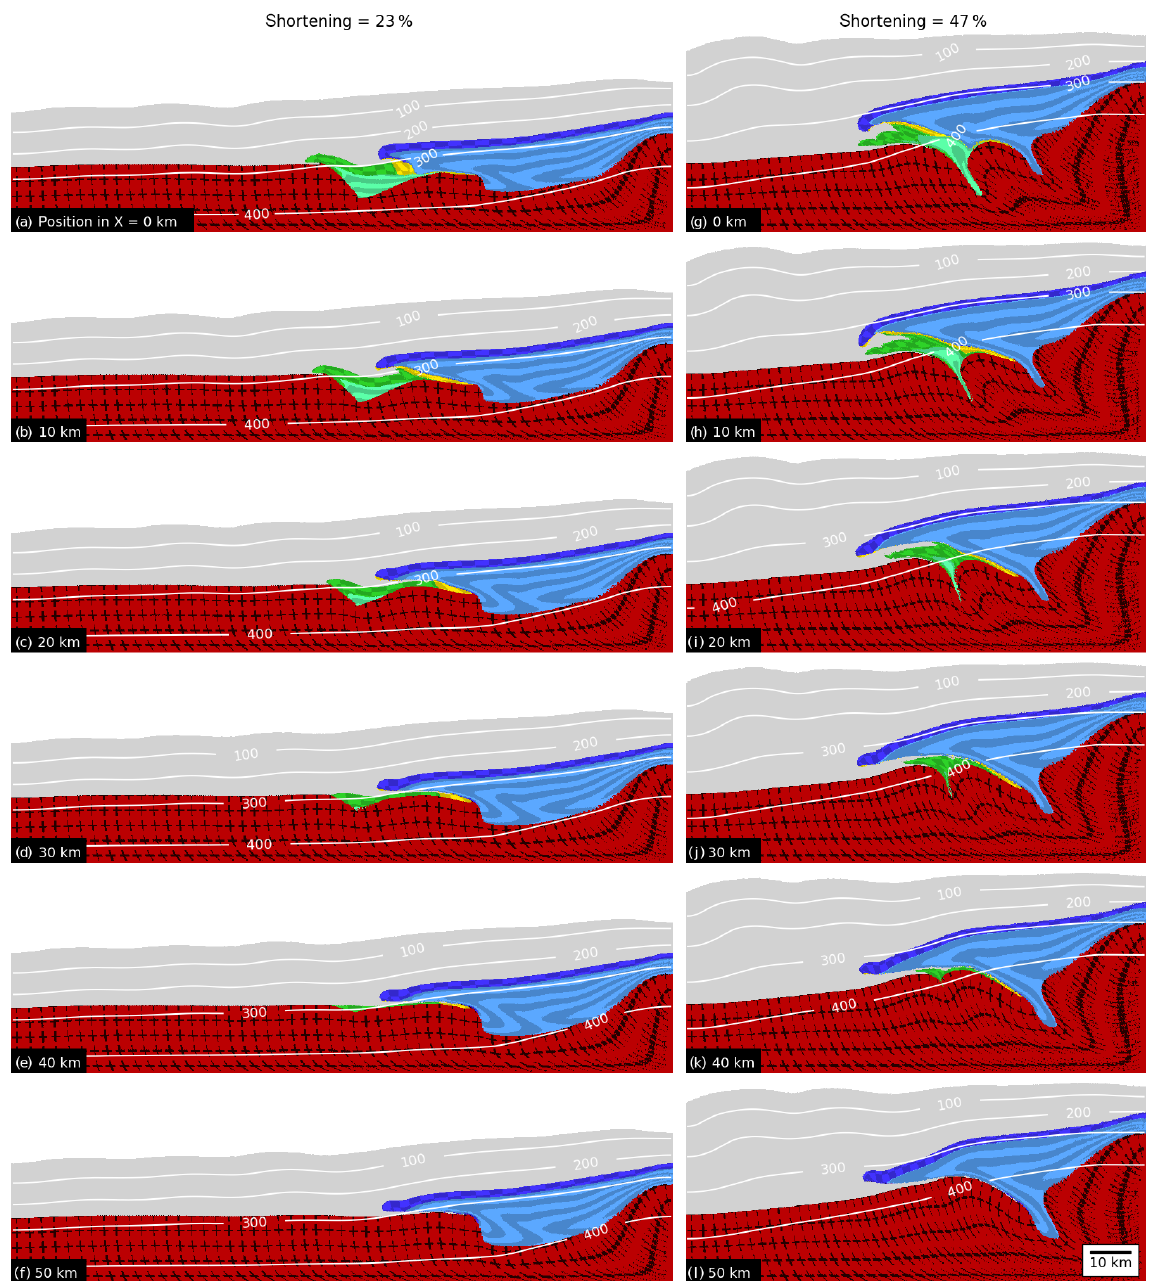
Figure 9. Graph showing lateral cross sections for two different states of bulk shortening for the geometrical evolution of model B.G-1. Cross sections are taken in 10km steps from X = 0 to X = 50km. Additionally, we display the isothermal lines in degrees Celsius ( ◦ C). Columns correspond to the bulk shortening state and rows to cross-section X